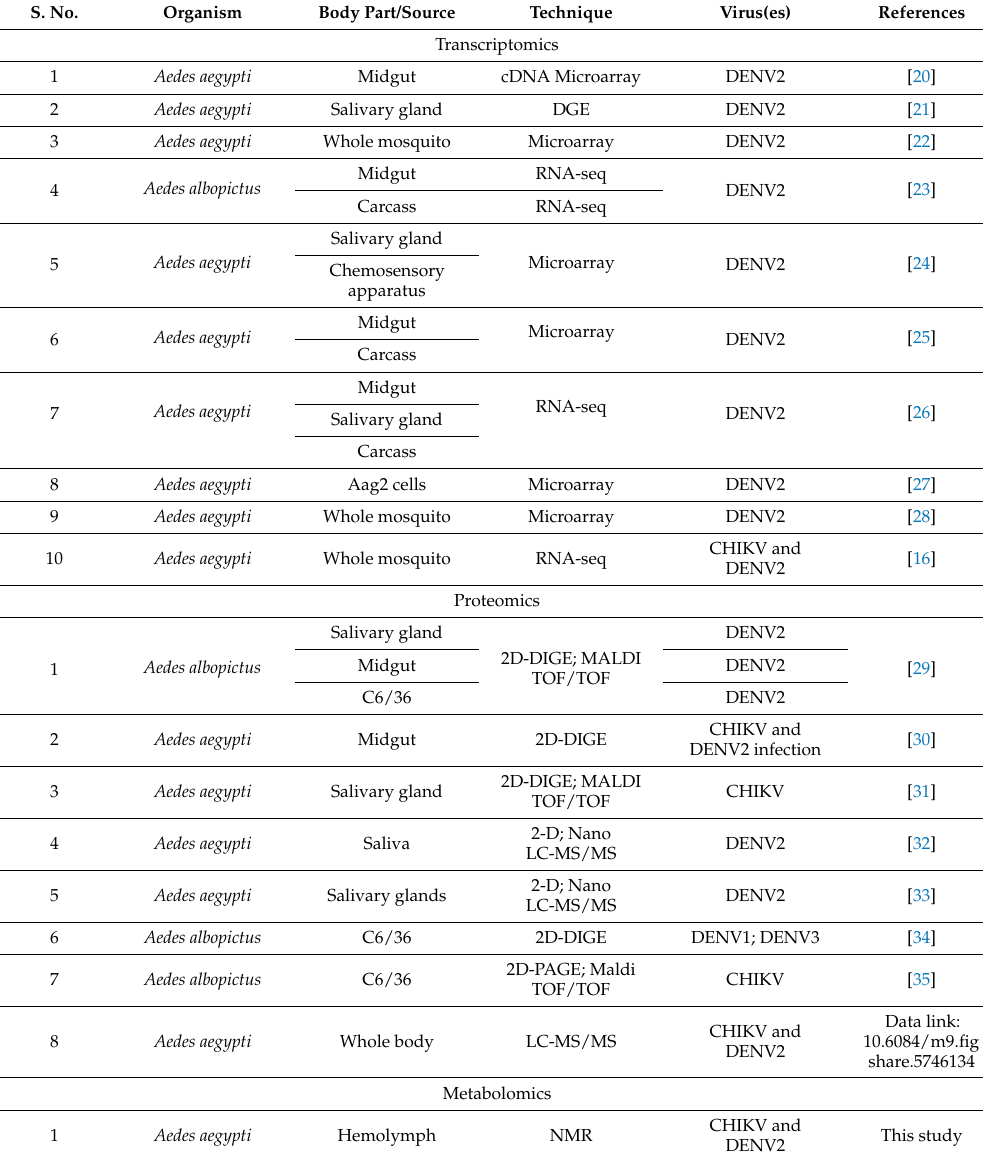
Table 3. List of selected data used in this